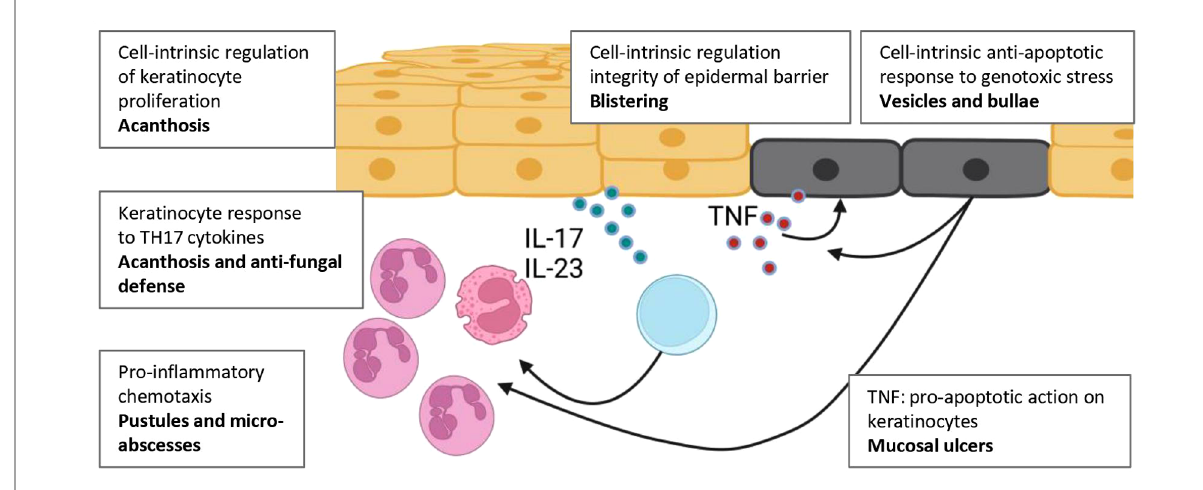
FIGURE 3 Overview of skin pathologies in which NF- κ B is thought to contribute. NF- κ B acts cell-intrinsically within keratinocytes, haemopoietic cells and other cells of the dermis, including fi broblasts (not shown). Cell-intrinsic defects in keratinocytes affect their proliferative capacity, propensity to undergo apoptosis, and capacity to contribute to the local antimicrobial response. NF- κ B signalling also mediates (at least in part) keratinocytes responses to exogenous stimuli including pro-in fl ammatory cytokines (TNF, IL-1 β ) and Th17 cytokines. Keratinocyte activation and apoptosis can stimulate production of these cytokines. Created with BioRender.com.